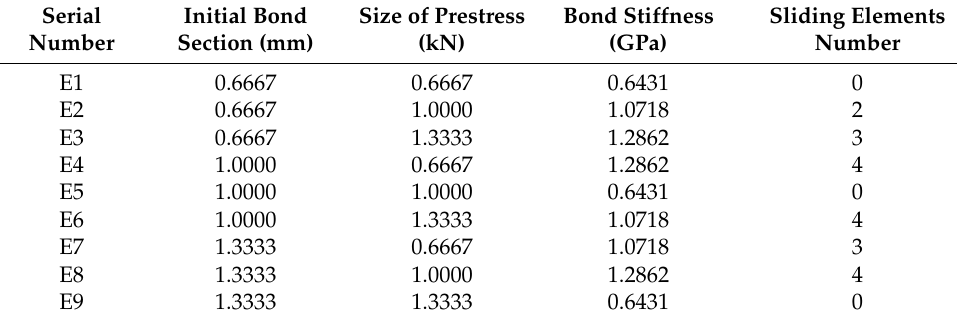
Table 3. The orthogonal test data mean value dimensionless